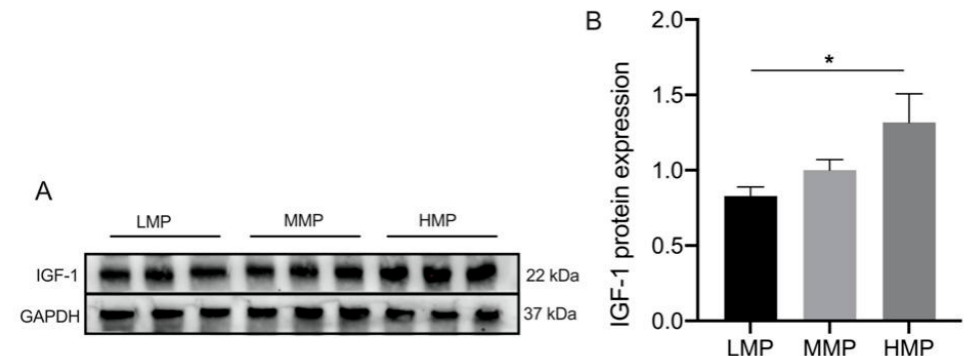
Figure 4. Expression of IGF-1 protein in plasma among three groups. (A) Representative Western blotting of IGF-1. (B) Protein abundance of the IGF-1. This experiment was repeated 3 times, and data are reported as mean ± SEM. * p < 0.05. LMP: low milk protein concentration group; MMP: medium milk protein concentration group; HMP: high milk protein concentration group.